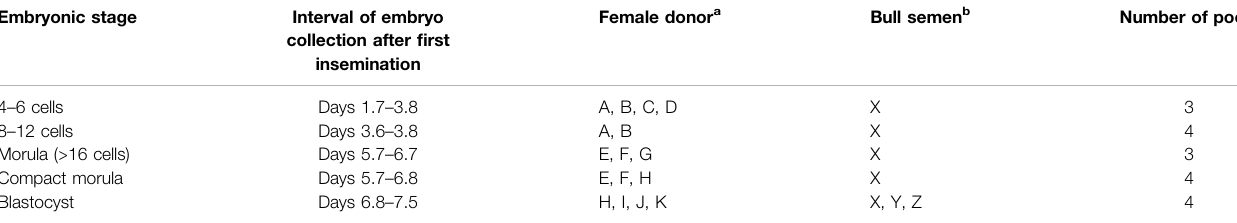
TABLE 1 | Pools of in vivo produced bovine embryos used for nanoLC-MS/MS analysis ( n = 4 embryos per pool). Embryonic stage Interval of embryo collection after fi